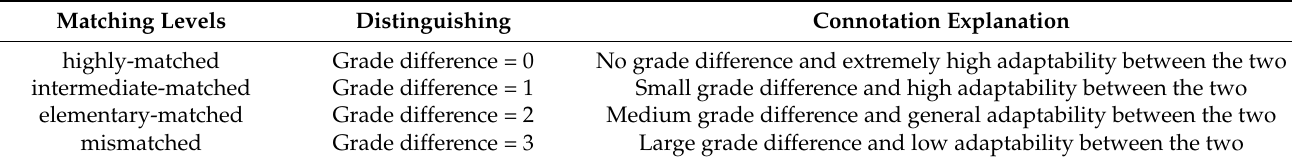
Table 1. Ranking criteria of matching and its connotation